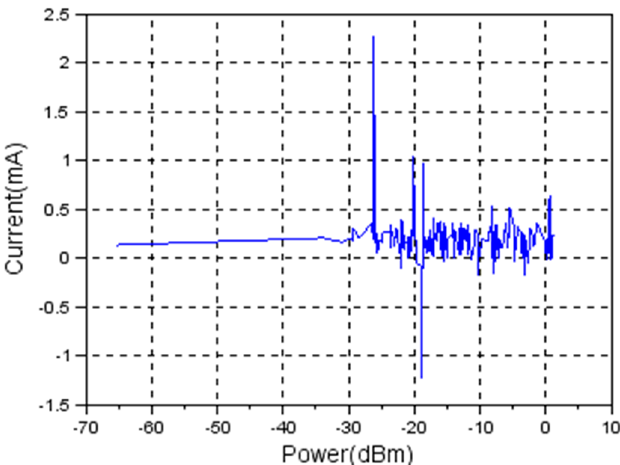
Figure 13. Current vs. transmission power. Current consumption difference caused by a voltage drop of 0.48 Volts.